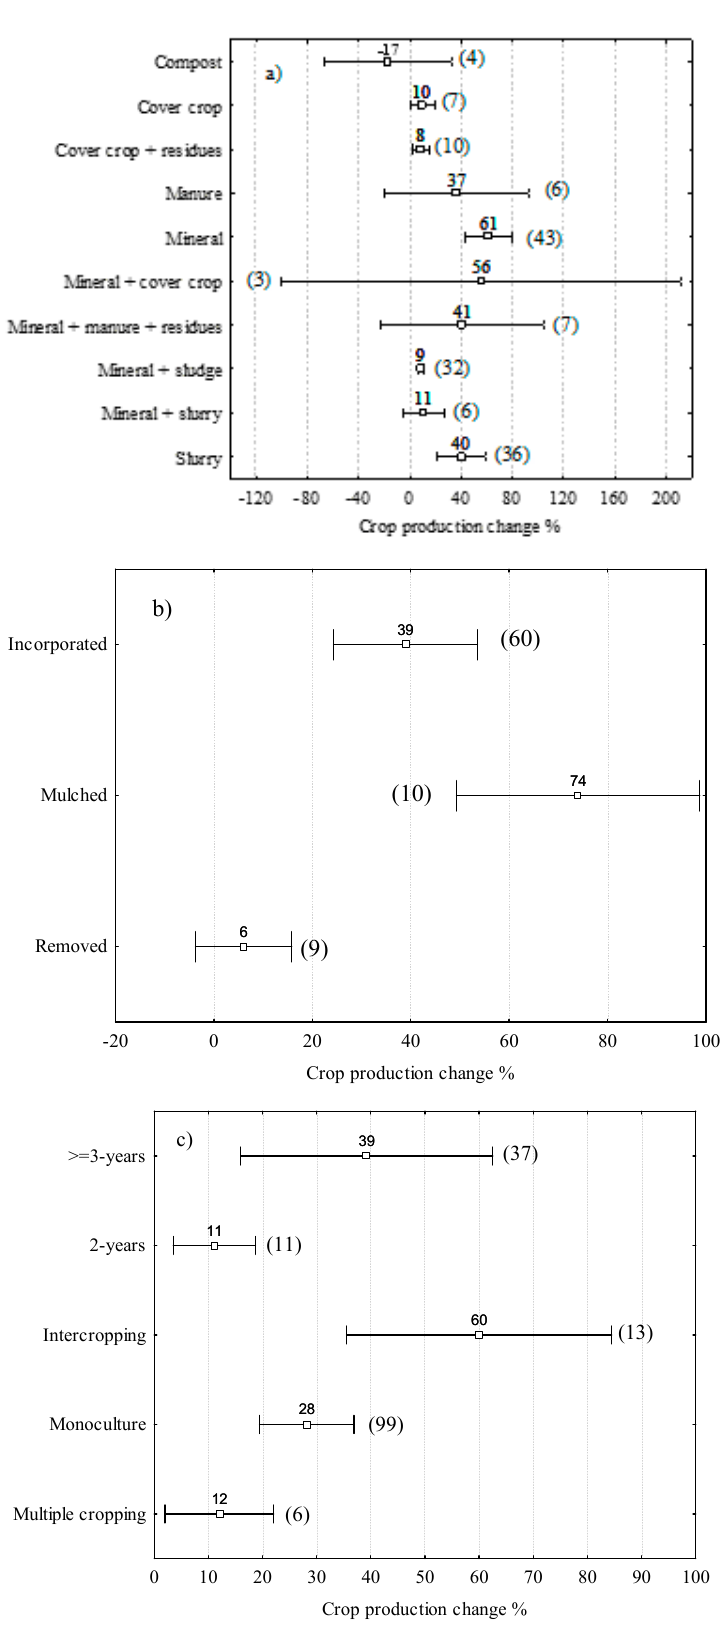
Figure 5. Mean plot of crop production change (%) in fertilization management vs. control fertilization grouped by: ( a ) fertilization type, ( b ) crop residue management, ( c ) crop diversification. Box–Whisker plots represents central point means, and 95% confidence interval. Numbers in brackets represent the number of comparisons used in each category. Note: the literature from the boreal zone was not as inclusive as for the other regions.